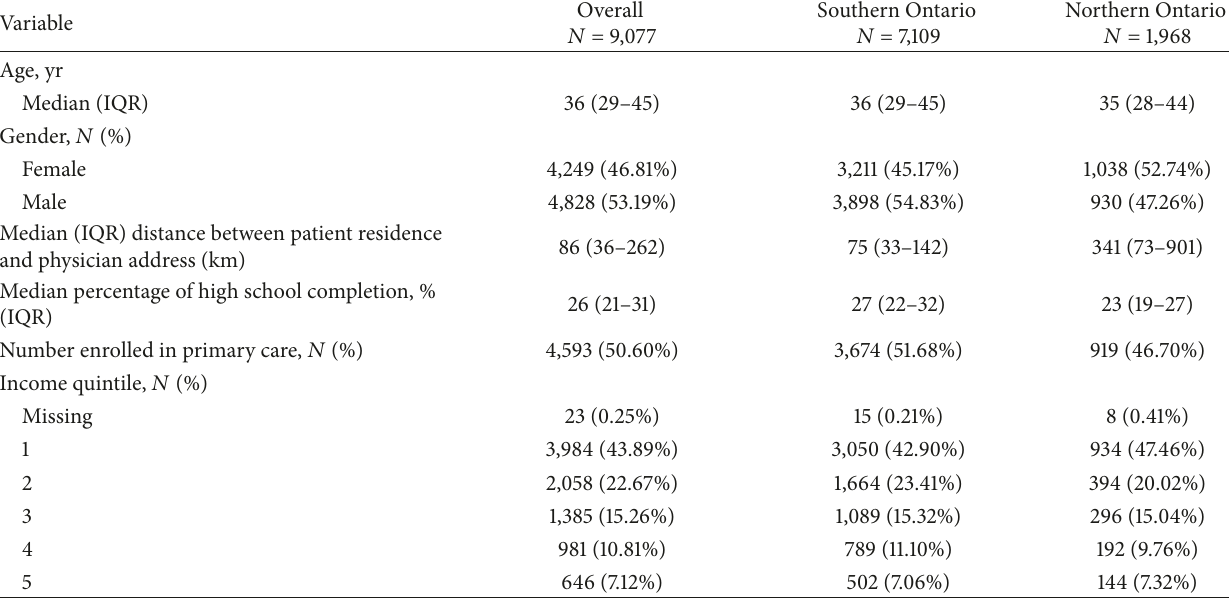
Table 3: Characteristics of patients receiving psychiatry via telemedicine by geographic